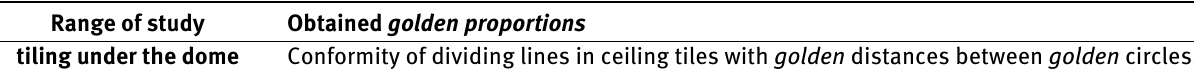
Table 4: The result of analysis of decorations Range of study Obtained golden proportions tiling under the dome Conformity of dividing lines in ceiling tiles with golden distances between golden circles.